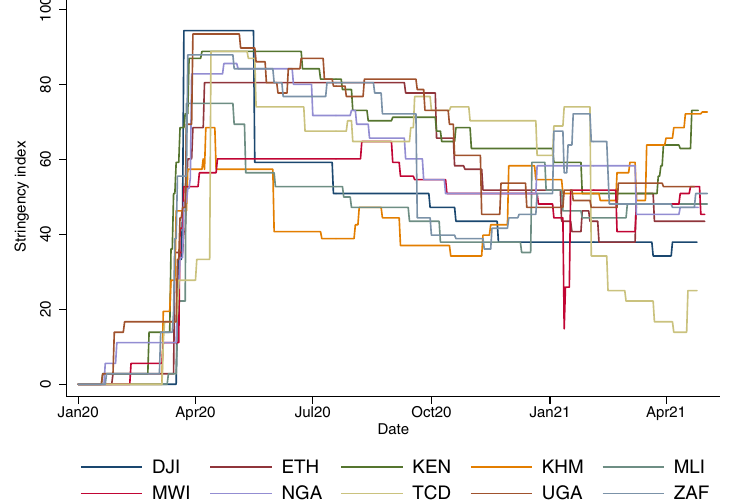
Figure 1. Stringency of government responses according to